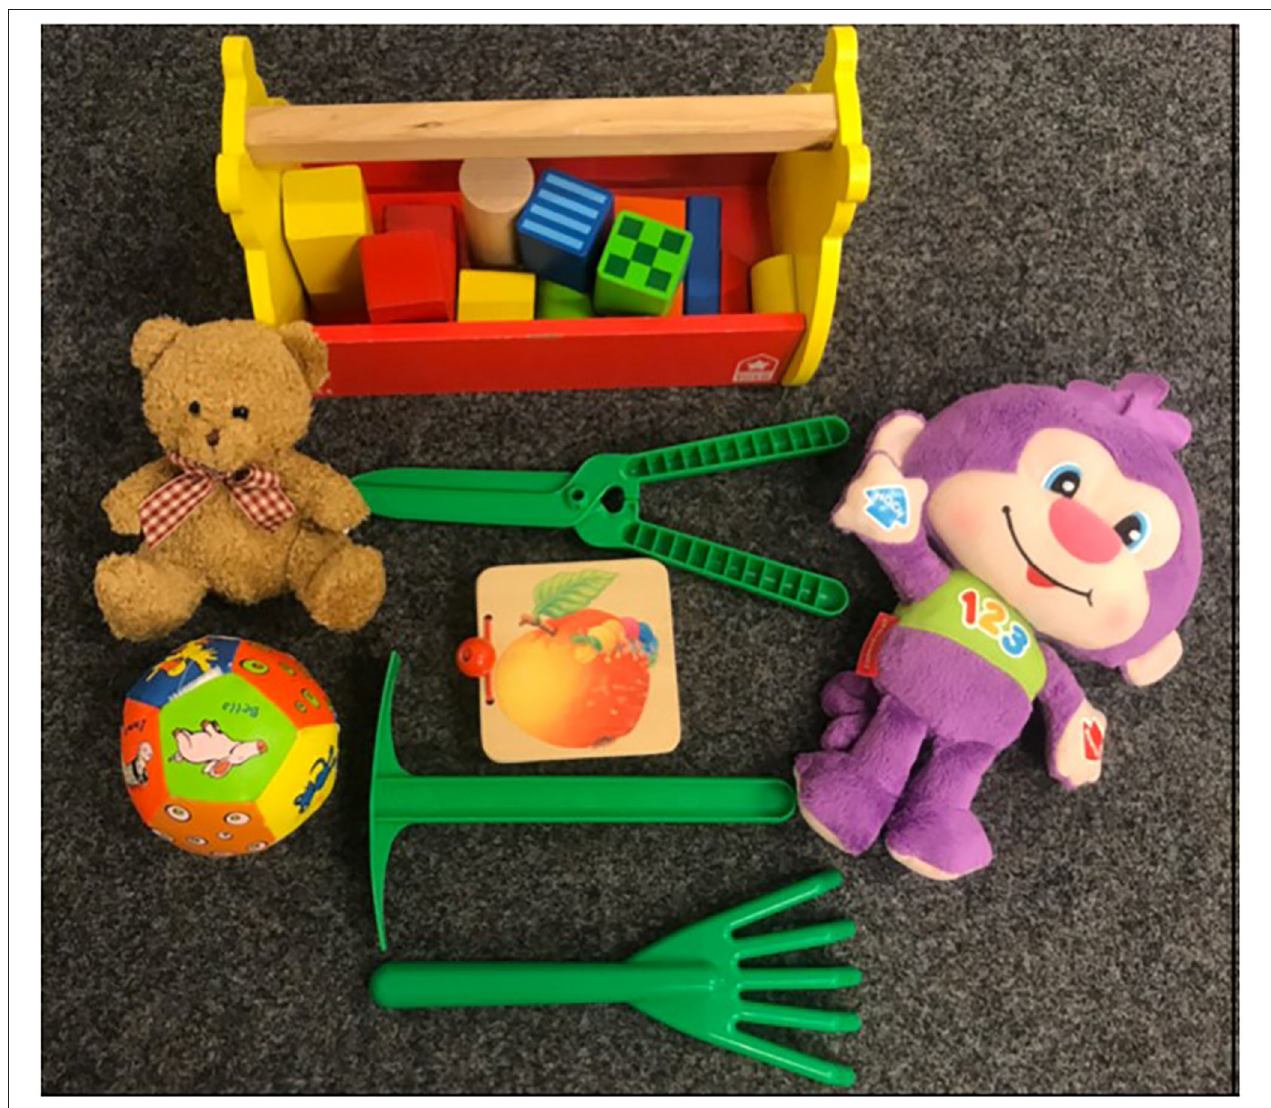
FIGURE 1 | Set of toys used during free